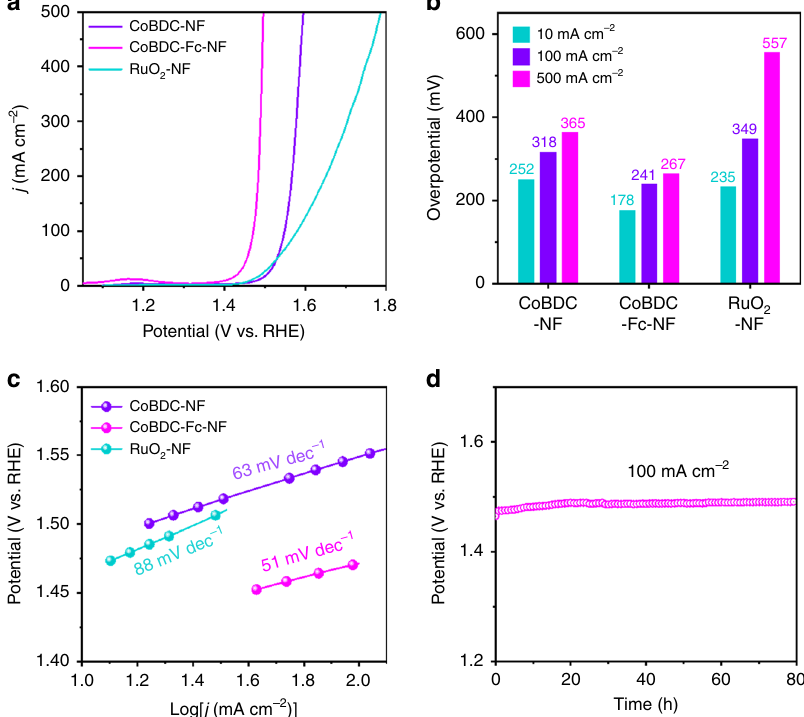
Fig. 5 OER performance. a Linear sweep voltammetry curves toward OER. b Overpotential at different current densities. c Tafel plots of different catalysts. d Chronopotentiometry curves of CoBDC-Fc-NF for 80 h at 100 mA cm − 2 in 1 M